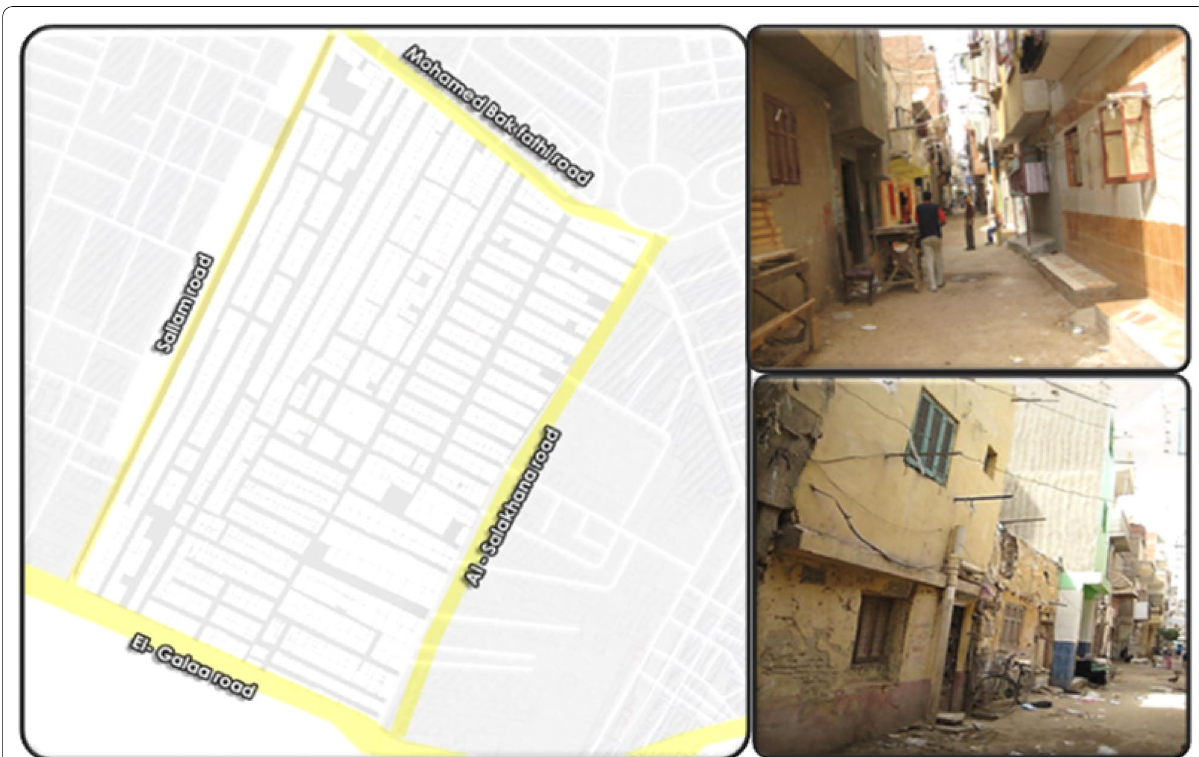
Fig. 5 Showing the urban Patterns and land